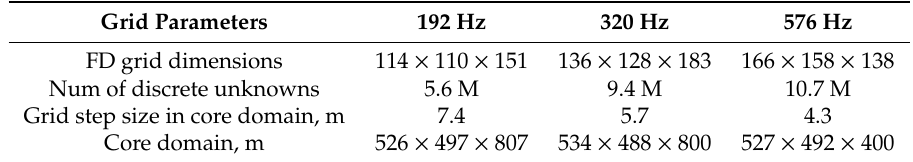
Table 3. Parameters of the finite-difference grids.